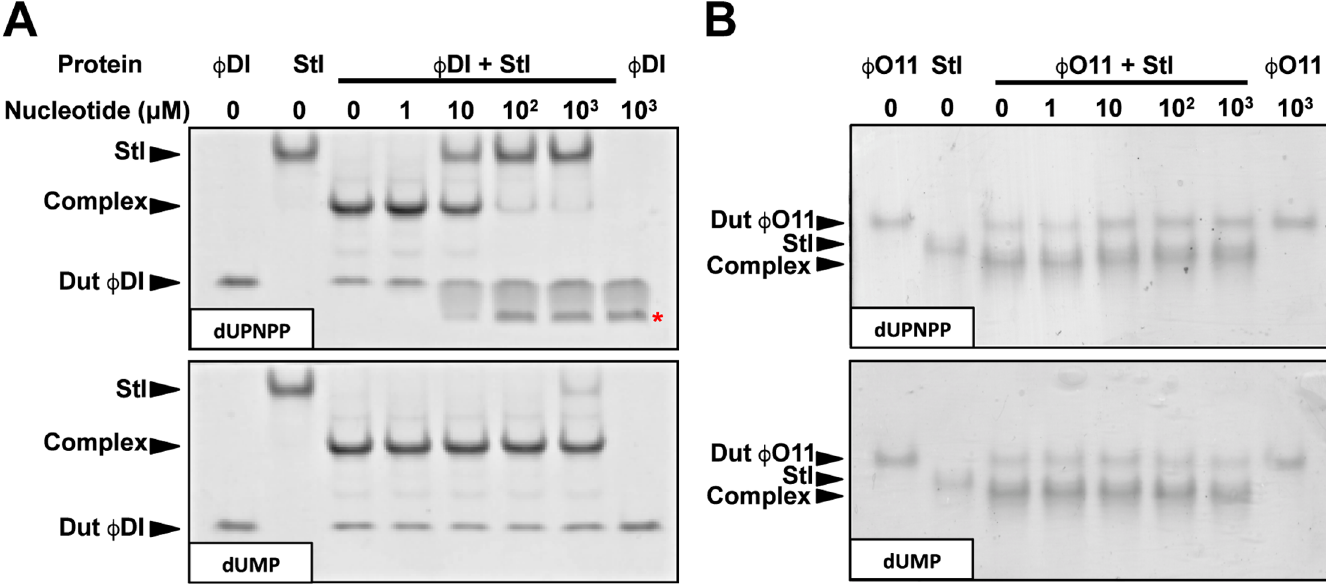
Fig 5. The dUTP substrate but not the dUMP product reduces the Dut-Stl interaction. Native-Page gels were performed to analyzethe effect of the substrate and product on the interaction of two inducingdimeric Duts, (A) ϕ DI and (B) ϕ O11, with Stl. Increasingconcentrations (from 0 to 1000 μ M) of dUPNPP (top gels) or dUMP (down gels) were added to equimolecular concentrations of each Dut with Stl, and the Dut-Stl complex formation was evaluatedby Native-PAGE. Notice the reduction of the Stl-Dut complex band when the dUTP analoguebut not the dUMP product was present. For ϕ DI a new band (labeledwith a red asterisk) corresponding to the complexbetweendUPNPP and the Dut can be observedwhen the Stl-Dut complexdisappears. For each experiment a representative gel of 3 independentsassays is shown.